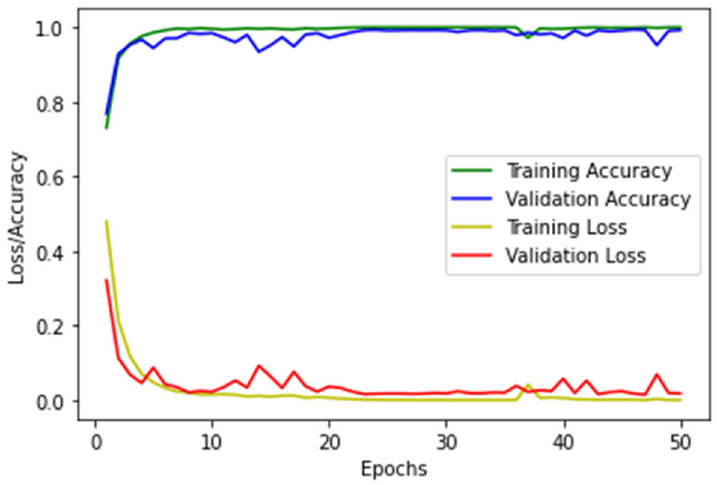
Figure 8. Training and validation progress of MobileNet.